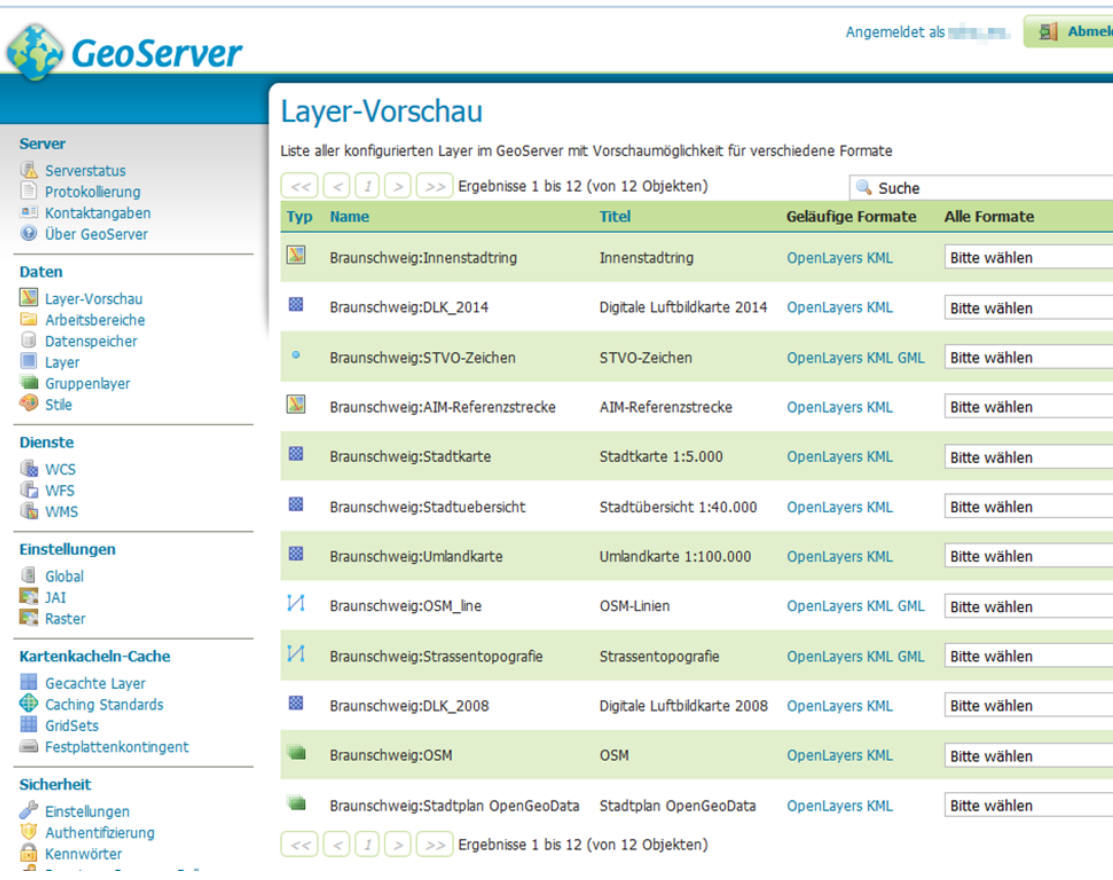
Figure 6: Preview of spatial data